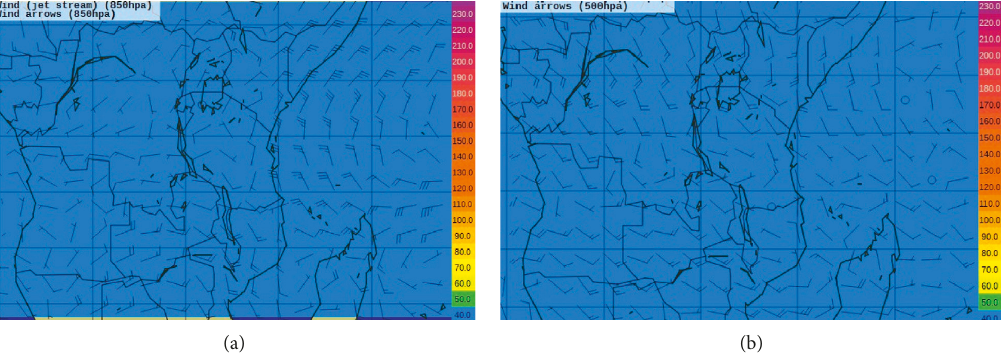
Figure 4: (a) Wind at 850hPa and (b) wind at 500 hPa all from NOAA-GFS on Wednesday 2018-01-10 06:00 UTC (all the graphs generated using zyGRID-grib files visualization software, available at http://www.zygrib.org/).